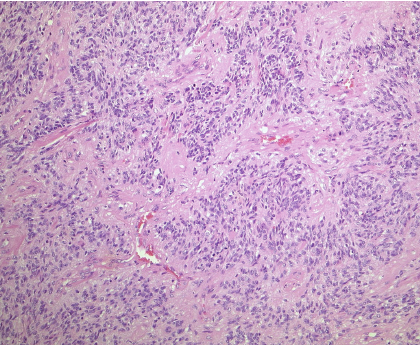
Figure 3: Sheets of monomorphic cells were interrupted by perivas- cular pseudorosettes (H&E, × 200, original